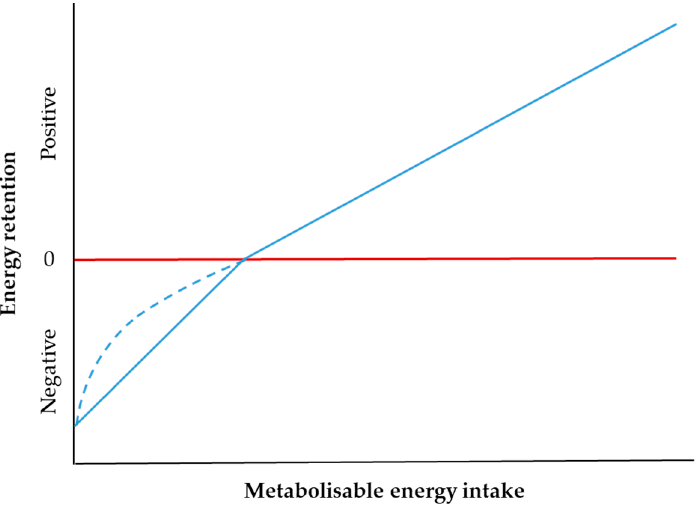
Figure 3. Effect of energy input on efficiency of utilisation above (K f ) and below (K m ) maintenance. The continuous blue line denotes the Agricultural Research Council assumption and the dashed blue line, the likely case. The red line denotes zero energy retention. Adapted with permission from [17].